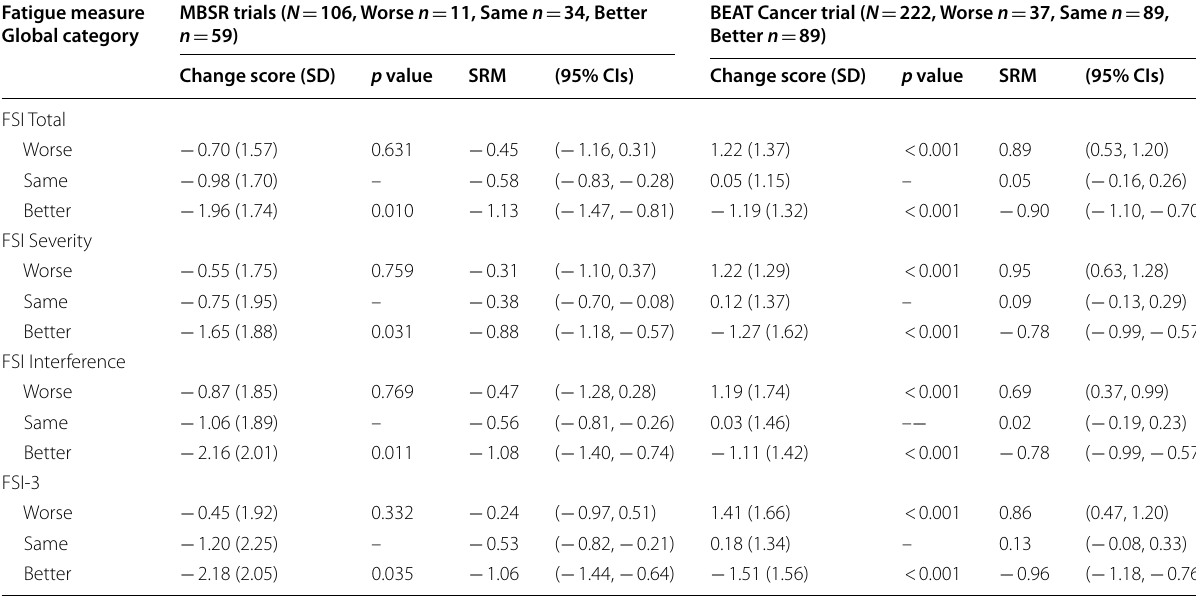
Table 2 Change scores and standardized response means for fatigue measures Fatigue measure Global